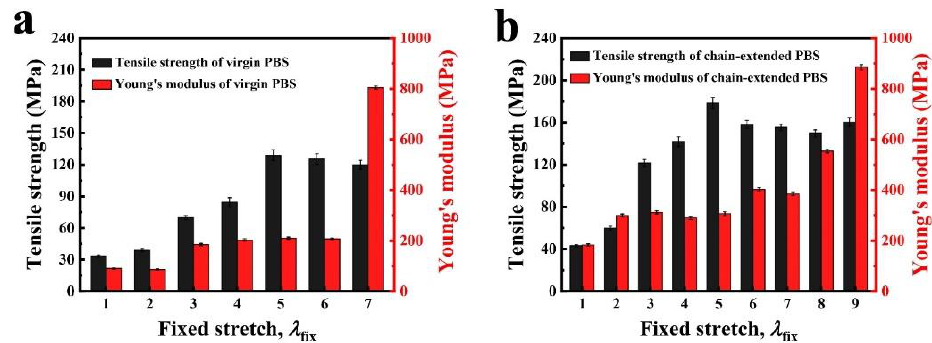
Figure 6. The Young’s moduli and tensile strengths of PBS samples. ( a ) Young’s moduli and tensile strength versus fixed stretch ( λ fix ) in virgin PBS. ( b ) Young’s moduli and tensile strength versus fixed stretch ( λ fix ) in chain-extended